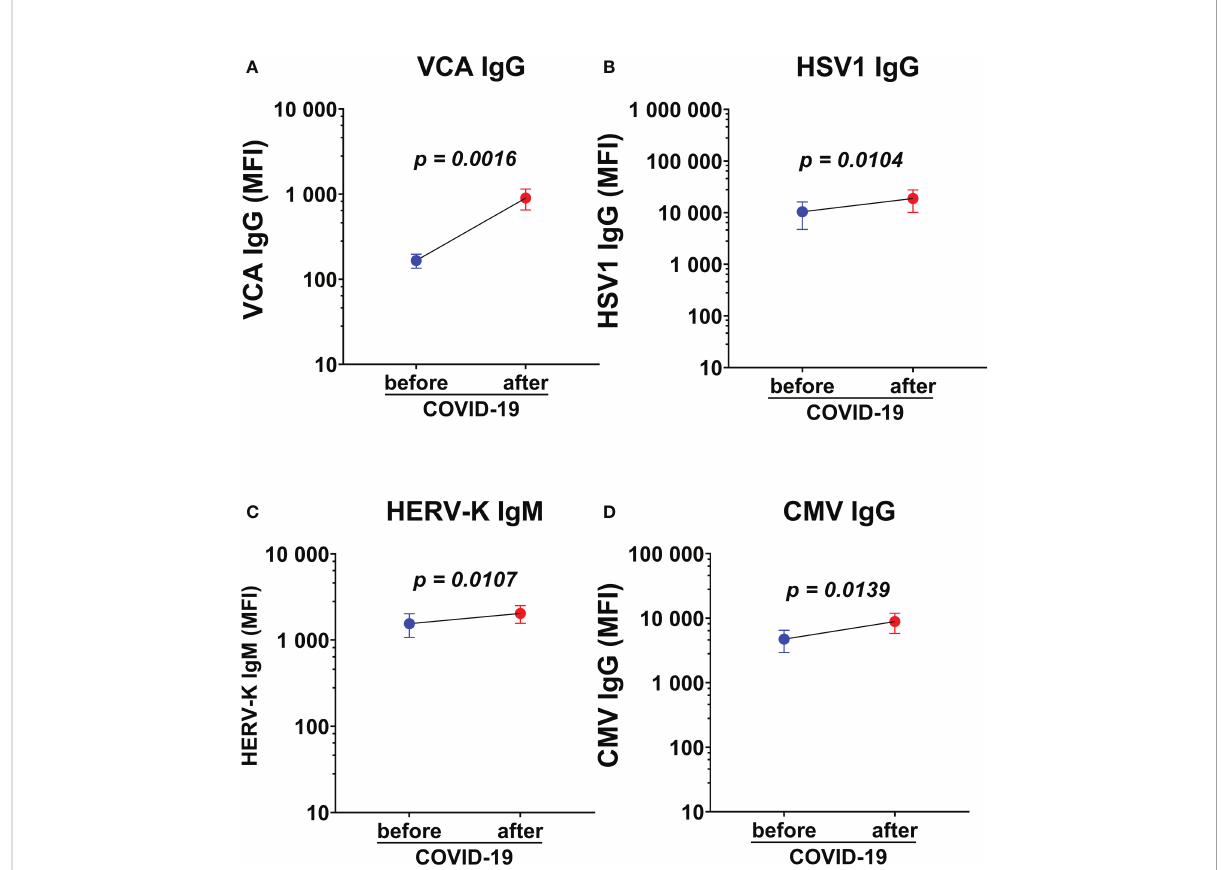
FIGURE 7 Paired analysis of saliva antibody reactivity to herpesviruses before and after SARS-CoV-2 infection. (A) Epstein-Barr viral capsid antigen (VCA) IgG, (B) herpes simplex-1 virus (HSV1) IgG, (C) endogenous retrovirus (HERV-K) IgM, and (D) cytomegalovirus (CMV) IgG in the same individuals before and after SARS-CoV-2 infection (n=19). Data are presented as mean antibody values with SEM of 19 individuals before and after infection. MFI, median fl uorescence index. Statistically signi fi cant differences according to paired Wilcoxon-signed rank test are indicated in the